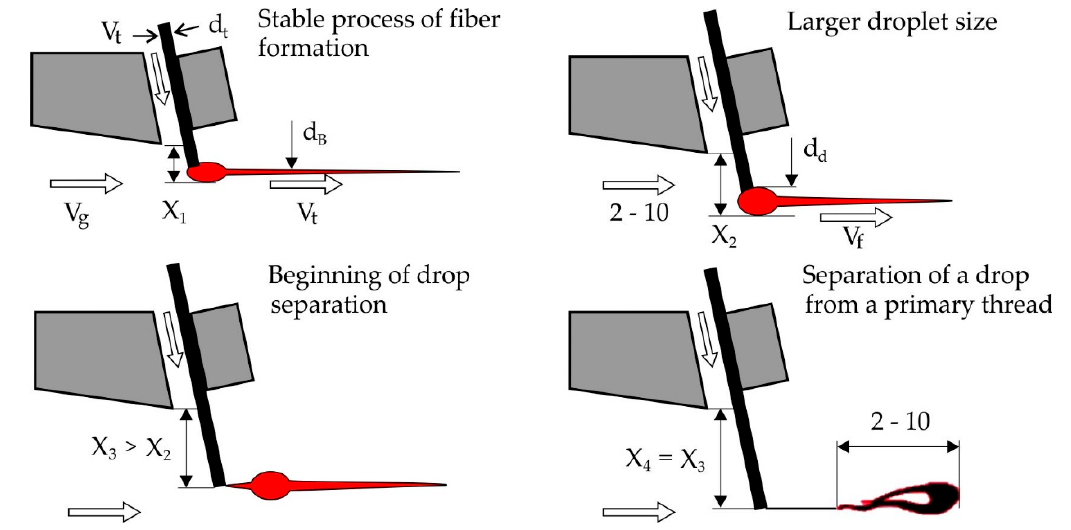
Figure 5. The process of forming loop-shaped non-fibrous inclusions.